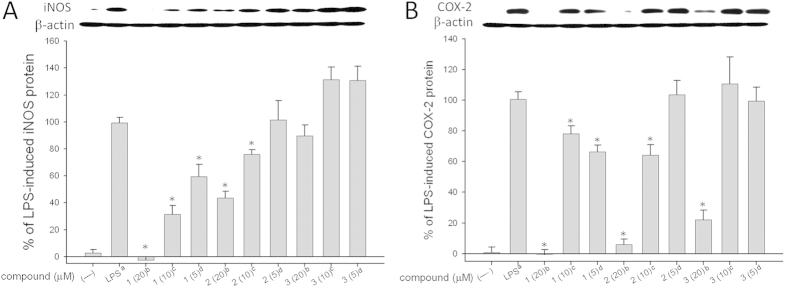
Effect of compounds 1–3 on iNOS and COX-2 protein expression of RAW264.7 macrophage cells by immunoblot analysis.(A) Immunoblots of iNOS and β-actin; (B) Immunoblots of COX-2 and β-actin. The values are mean ± SEM (n = 3). Relative intensity of the LPS alone stimulated group was taken as 100%. Under the same experimental condition CAPE (caffeic acid phenylethyl ester, 10 μM) reduced the levels of the iNOS and COX-2 to 2.5 ± 3.7% and 50.3 ± 8.7%, respectively. *Significantly different from LPS alone stimulated group (*p < 0.05). aStimulated with LPS. bStimulated with LPS in the presence of 1–3 (20 μM). cStimulated with LPS in the presence of 1–3 (10 μM). dStimulate with LPS in the presence of 1–3 (5 μM).